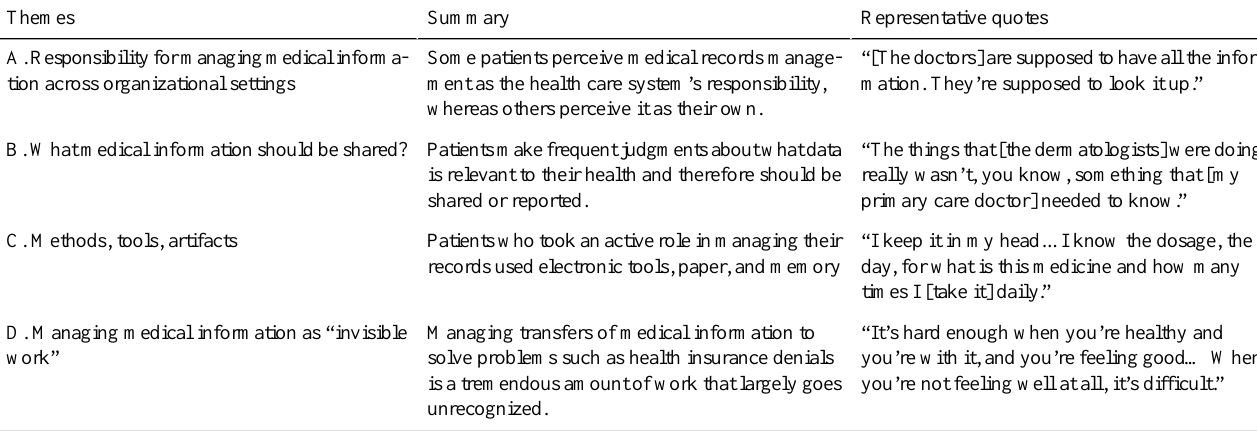
Table 1. Major themes in Personal Health Information